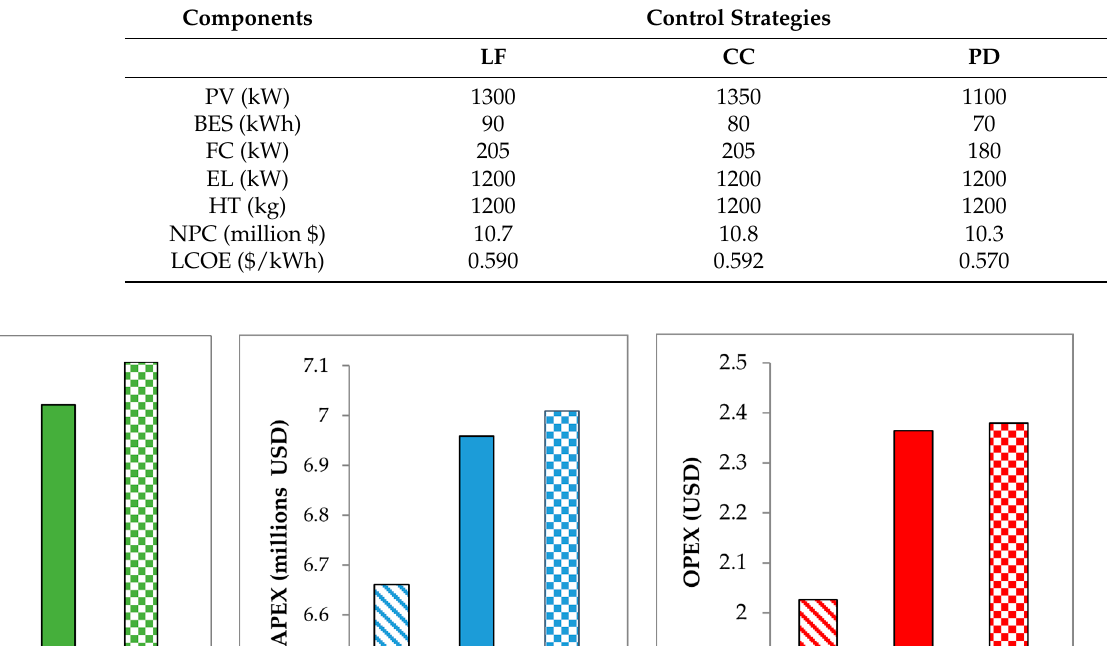
Table 4. Optimization results of LF, CC, and PD control strategies.